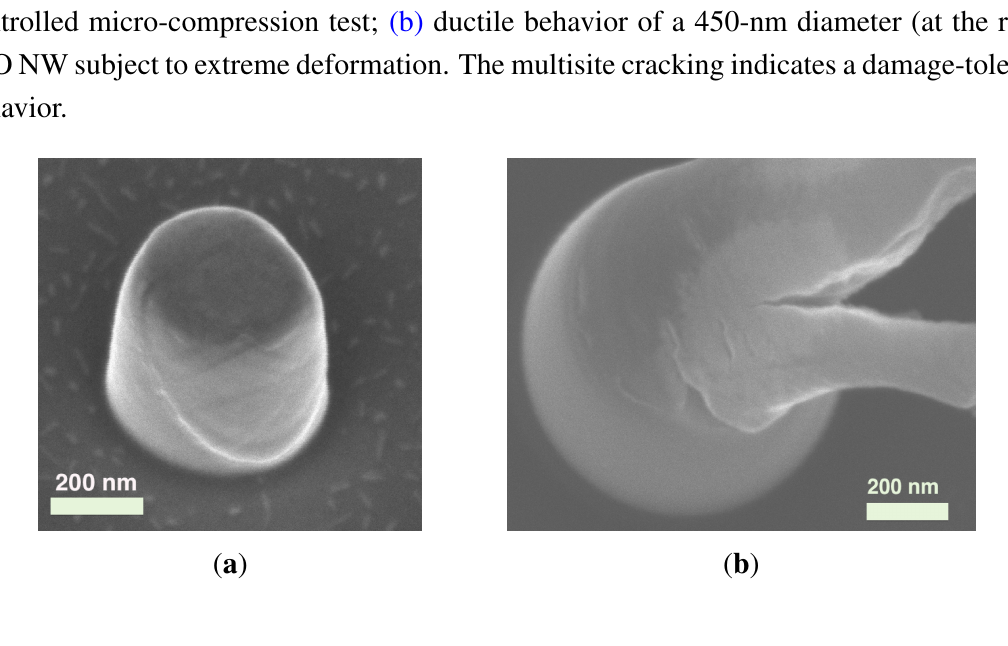
Figure 3. SEM micrograph of compressed ZnO nanopillar. (a) Ductile behavior under a controlled micro-compression test; (b) ductile behavior of a 450-nm diameter (at the